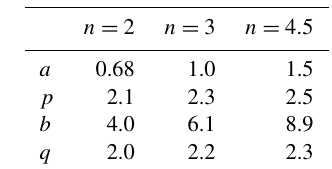
Table 4. Optimal parameters chosen for the expressions Eq. (29) for different n values.